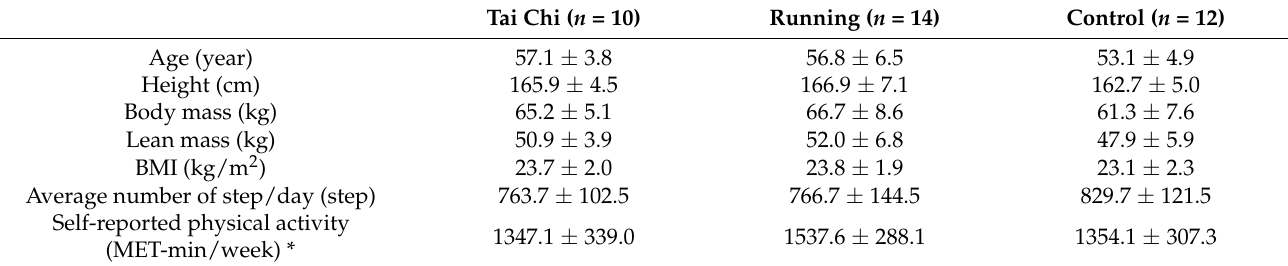
Table 1. Demographic characteristics of the participants by exercise